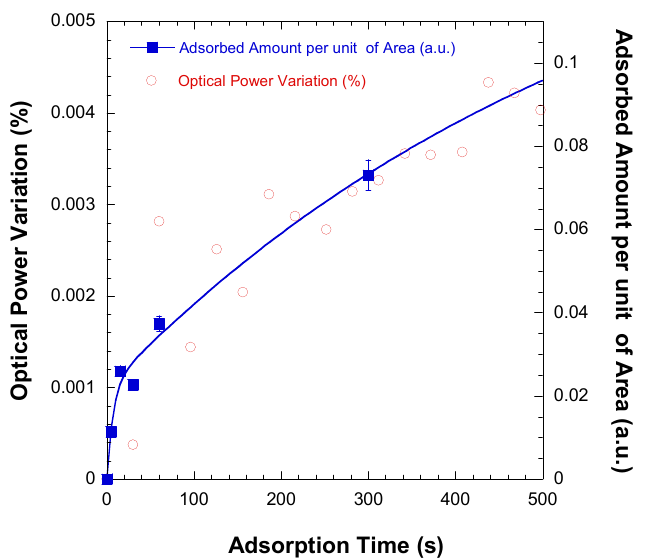
Figure 3. In situ kinetics of the adsorption of GO onto a (PEI/ GO) n /PEI thin film as measured by reflectance and by UV–visible spectroscopy (adsorbed amount per unit of area). The blue line corresponds to the fitting with Equation